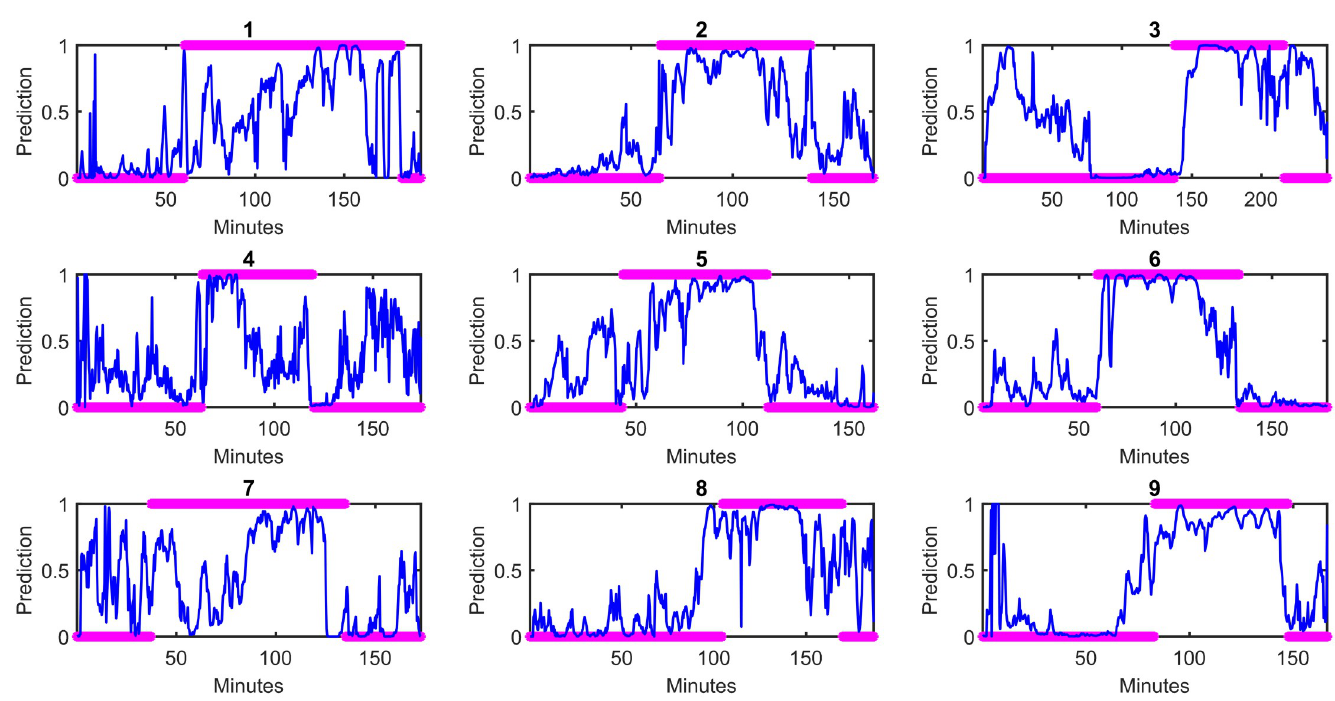
Fig 5. Autonomic predictions by subject from the best logistic regression model for Question 1. For each subject, the blue trace is the prediction of the model using autonomic indices, while the magenta asterisks indicate the state of consciousness based on behavior, where conscious is 0 and unconscious is 1.